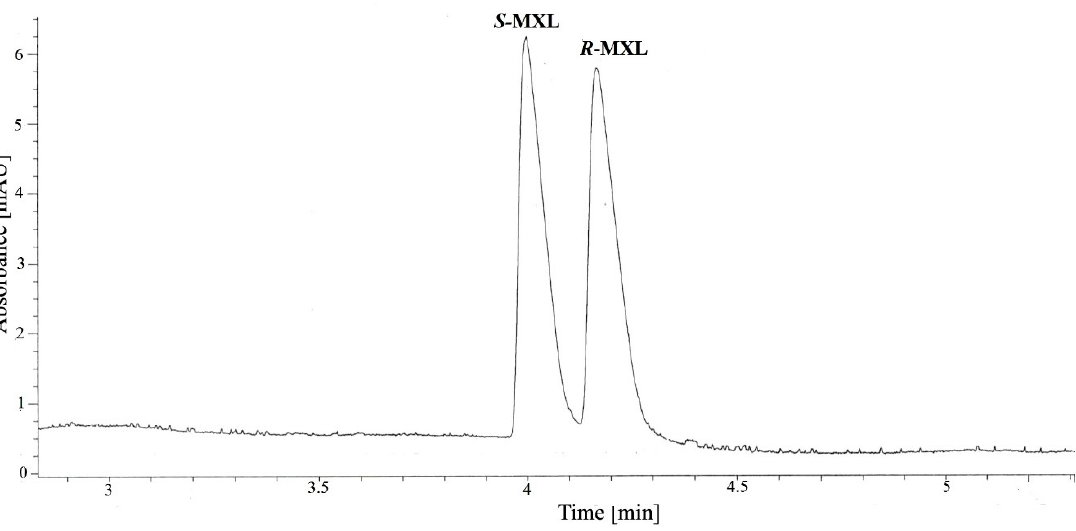
Figure 3. Chiral separation of MXL enantiomers under optimized analytical conditions (experi- mental conditions: 60 mM phosphate BGE, pH 5.0, 50 mM TM- β -CD, 20 °C, 30 kV, 50 mbar/s, 210 nm).